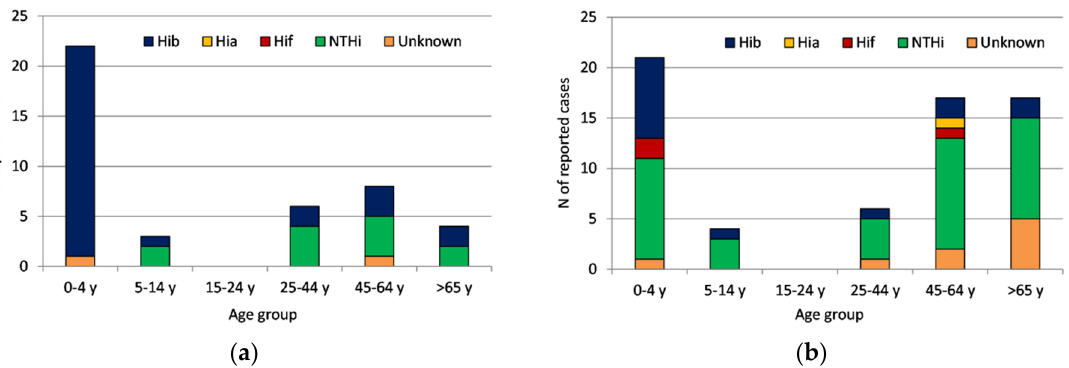
Figure 3. H. influenzae serotype distribution by age group during two study periods ( a )